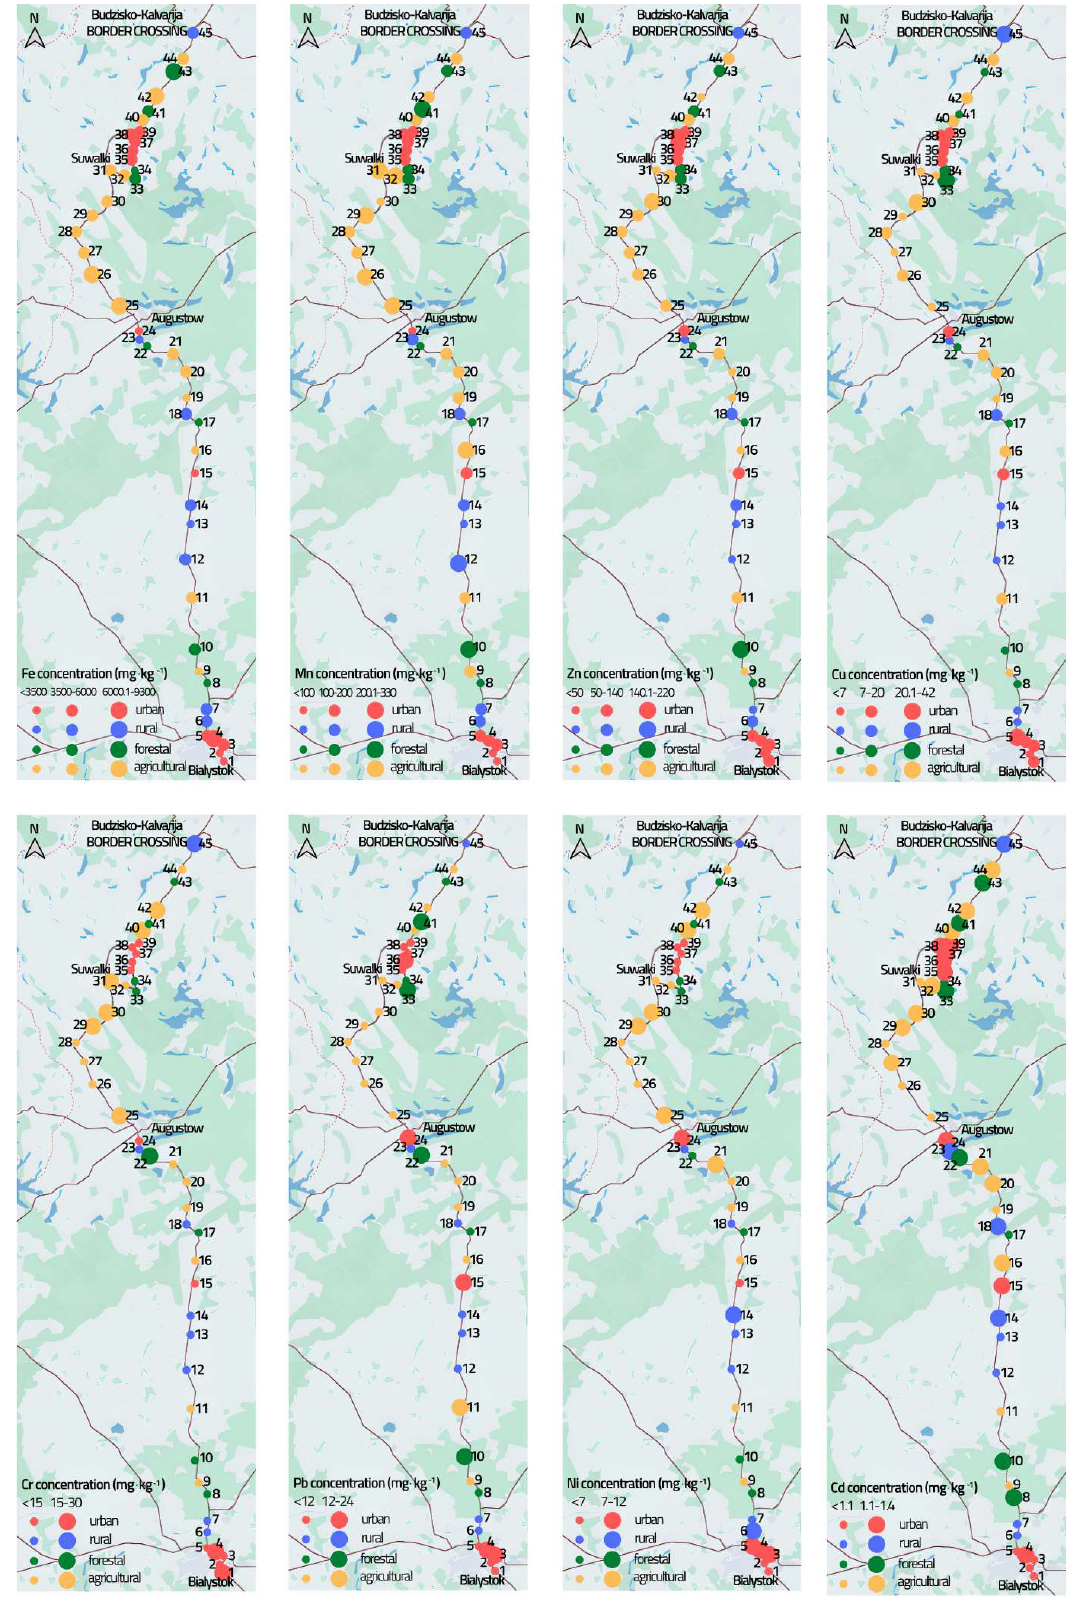
Figure 5. Spatial diversity of the metals along the route analyzed, taking into account the type of land use at the research